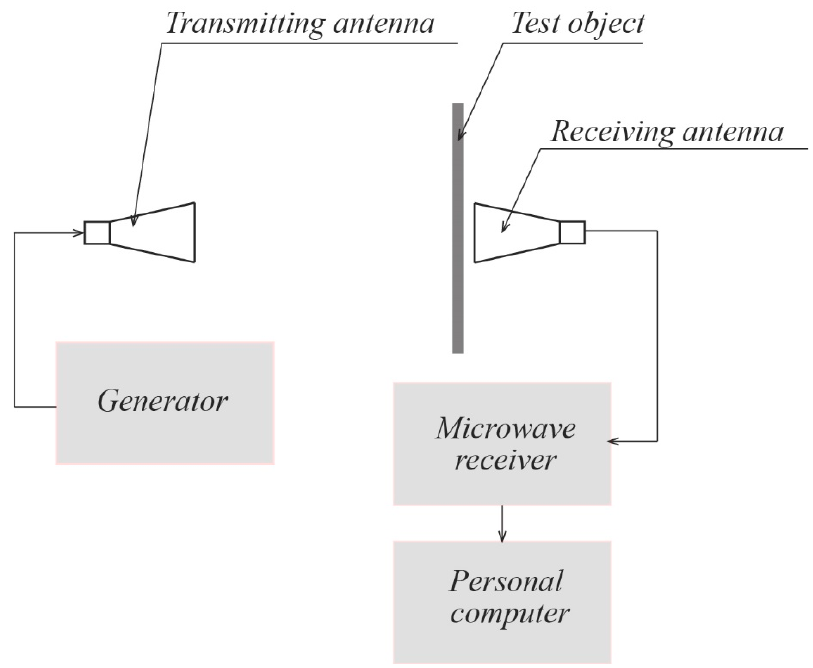
Figure 3. Scheme of the workplace for measuring the magnitude of energy losses.